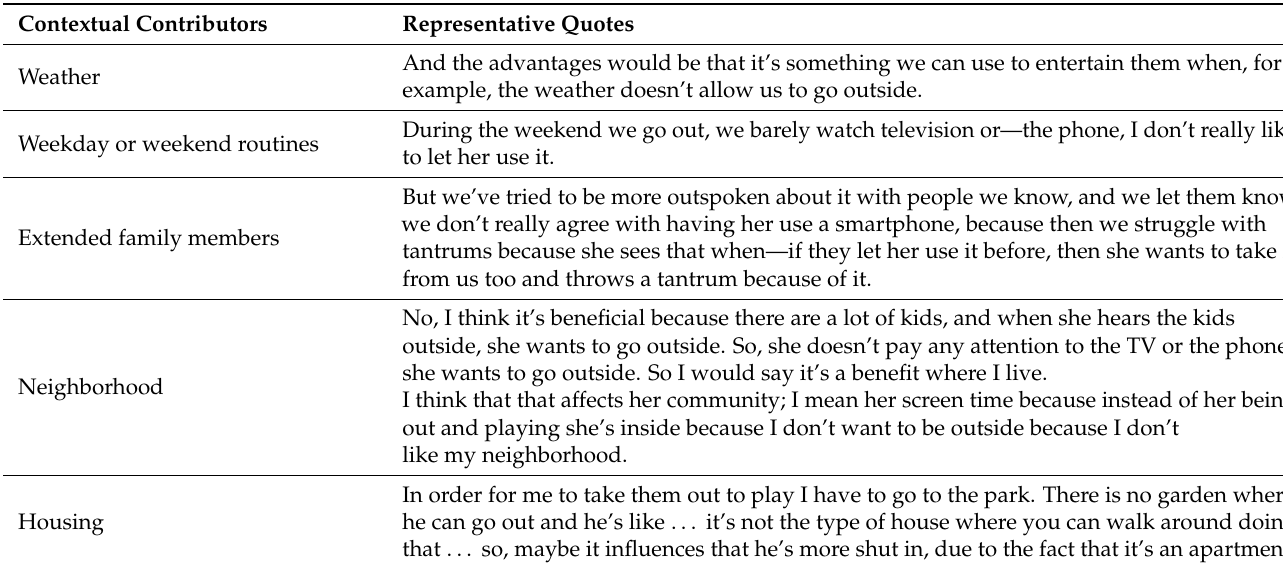
Table 4. Contextual contributors to screen use reported in In-depth interviews with Mexican Ameri- can parents of toddlers ( n = 32